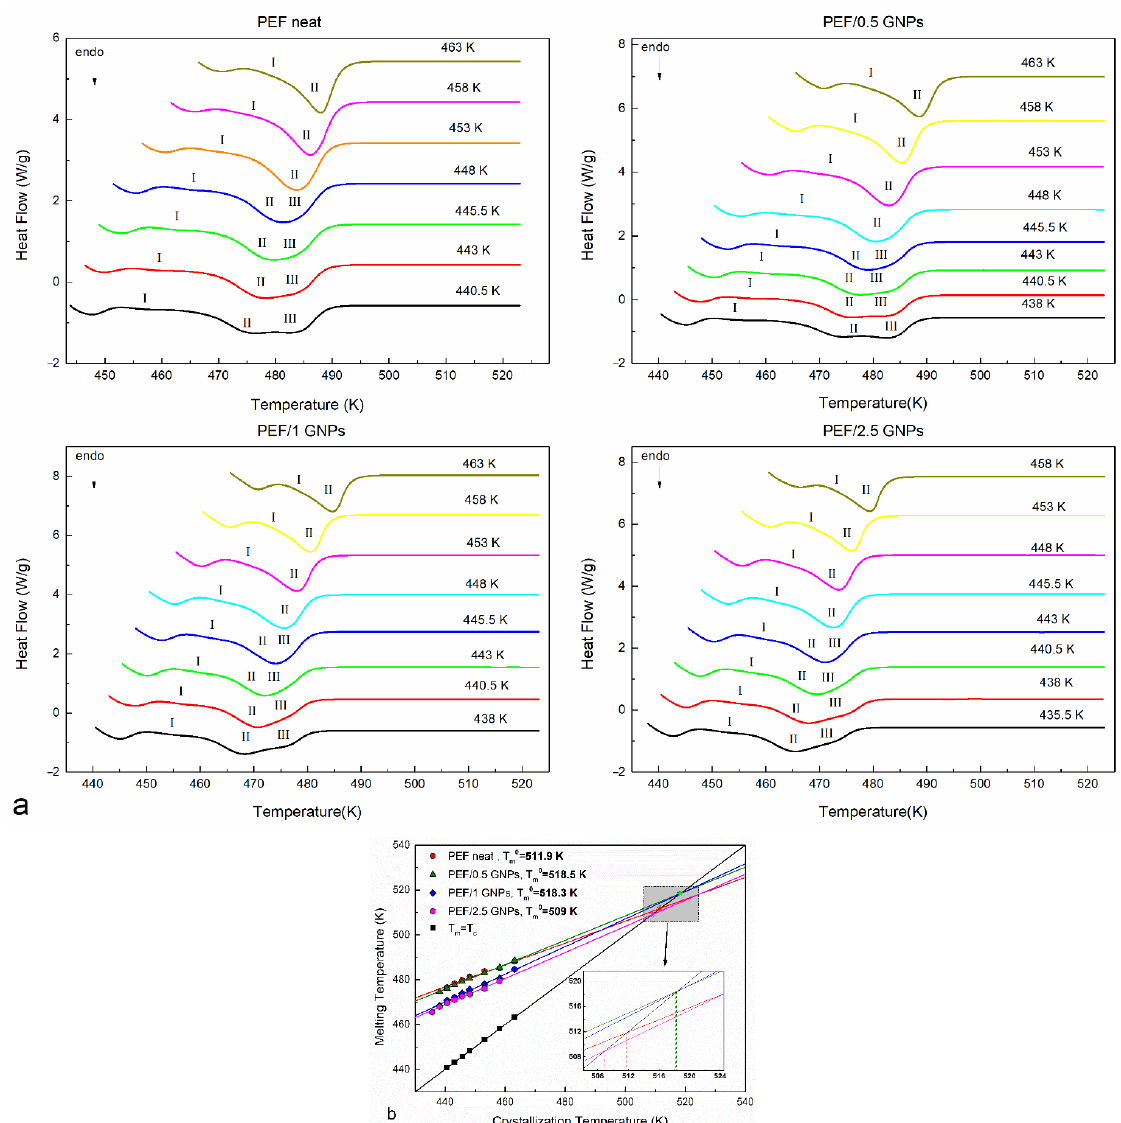
Figure 3. Subsequent melting curves after the isothermal melt crystallization at various temperatures ( a ) and Hoffman – Weeks plots ( b ) of the neat PEF and PEF/GNP nanocomposites. The Hoffman – Weeks plots of the recorded T mII , mapped against the corresponding isothermal crystallization temperatures of the neat PEF and PEF/GNP nanocomposites, are presented in Figure 3b. The calculated equilibrium melting temperatures are shown